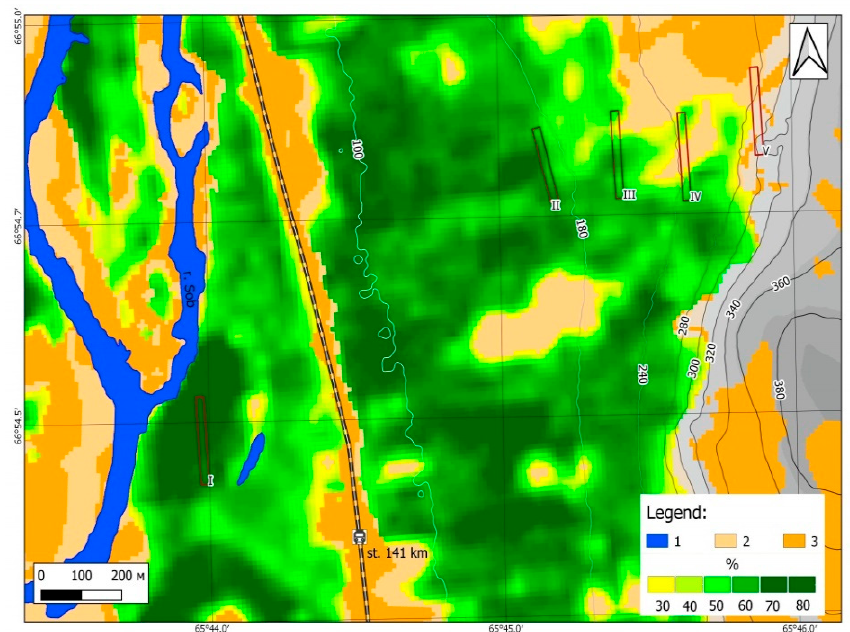
Figure 4. Map of Slantsevaya mountain with the studied altitudinal levels as well as parameters of forest crown density. Color legend: blue 1—water (Sob’ river), beige 2—grass communities, orange 3—stones; yellow to dark green transitional colors represent tree crown density (%).